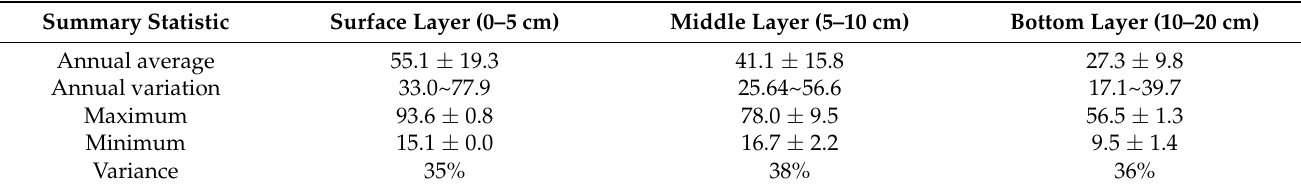
Table 1. Annual variation in available-P in sediments of Dianchi Lake (P mg kg − 1 ).